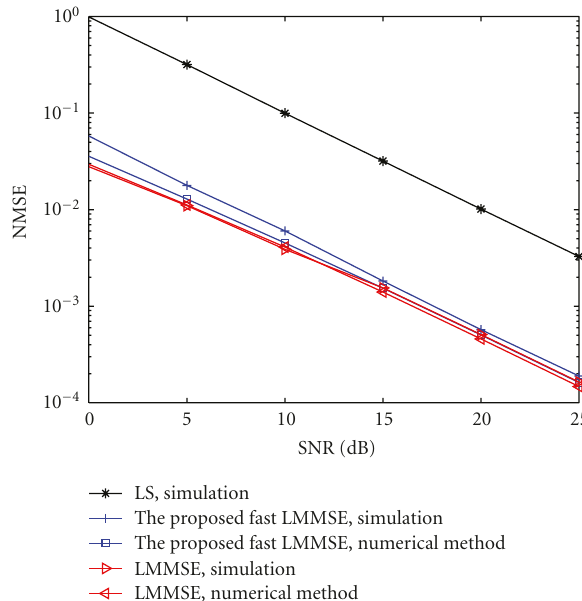
Figure 5: Normalized Mean square error (NMSE) of channel estimation of LMMSE algorithm versus that of the proposed fast LMMSE algorithm by computer simulation and numerical